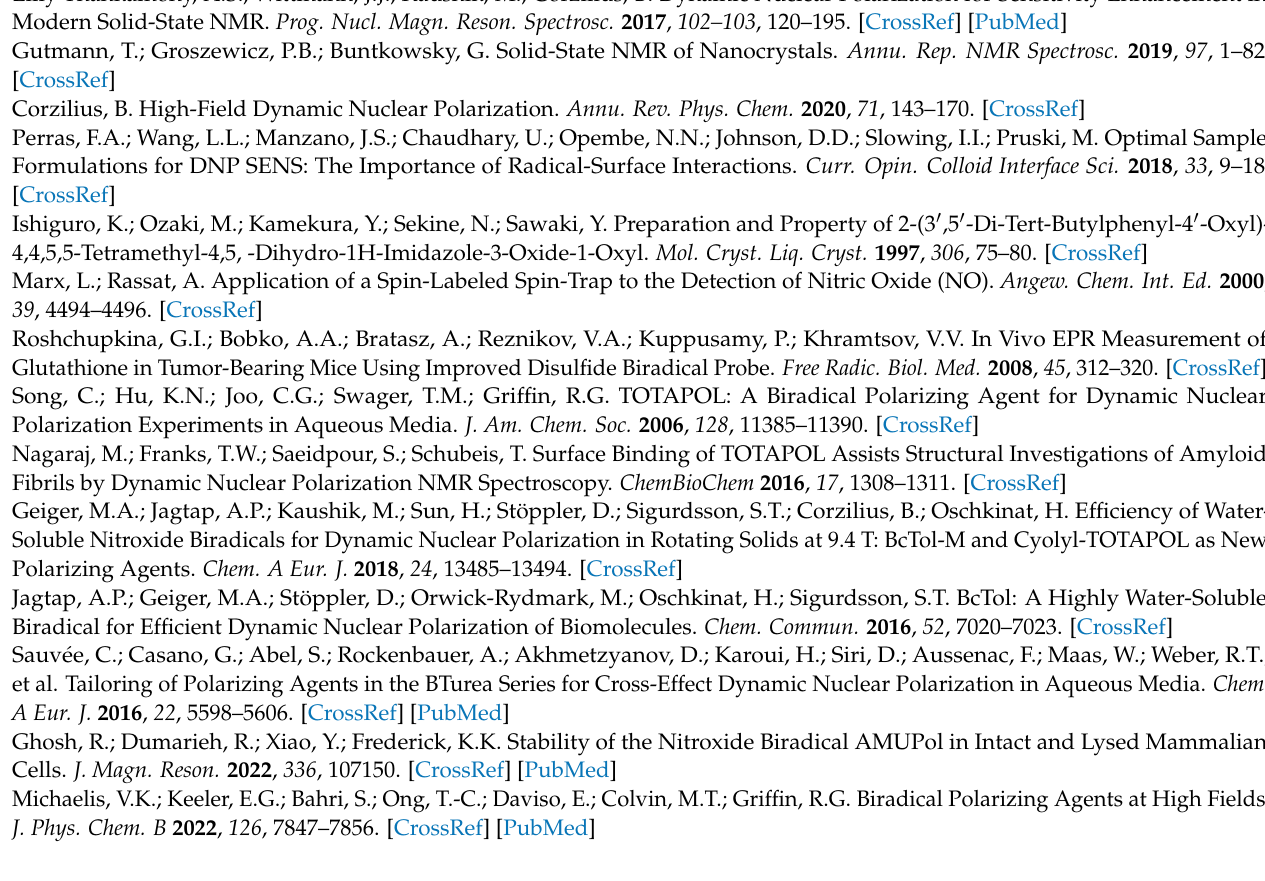
80 K. Figure S2. Left: Intensity of spin echo of biradicals 3 – 4 at 80 K as a function of the time. Right: Inversion-recovery time traces of biradicals 3 – 4 at 80 K along with mono-exponential fits. Table S1. Parameters of relaxation times for biradicals 3 – 4